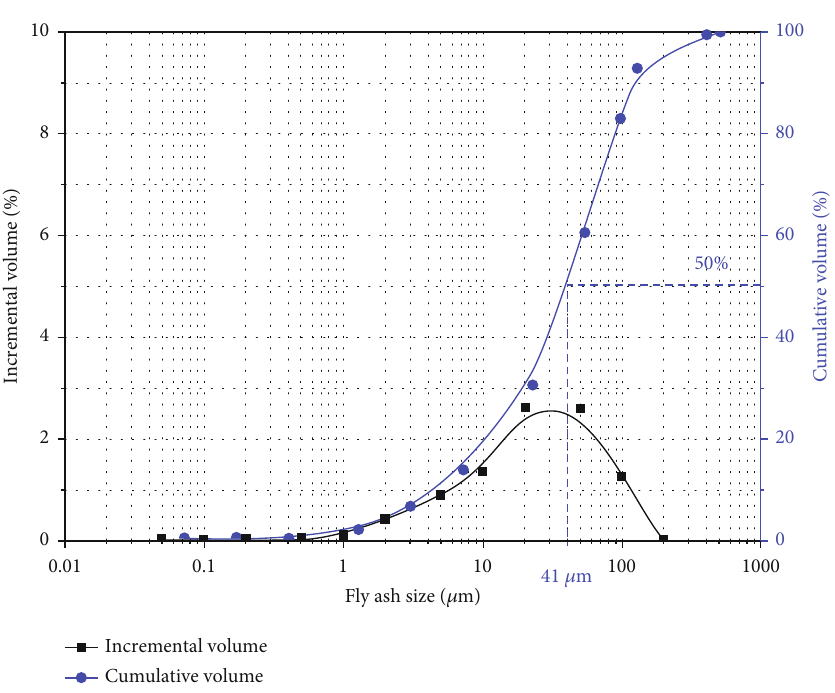
Figure 2: Fly ash particle size